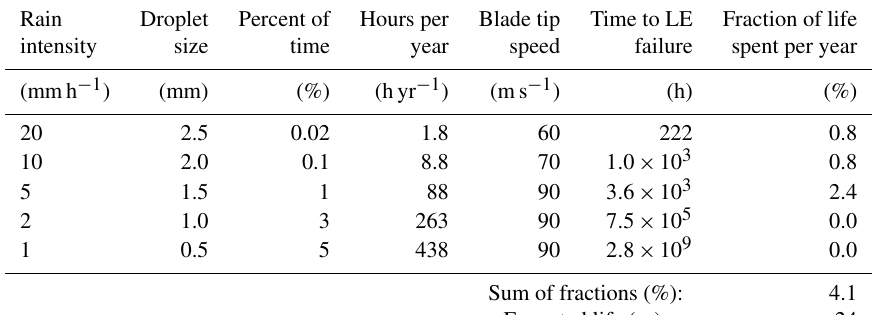
Table 6. Calculation of the expected lifetime of the blade leading edge with a reduction in the tip speed to 60 and 70ms − 1 : Control Strategy